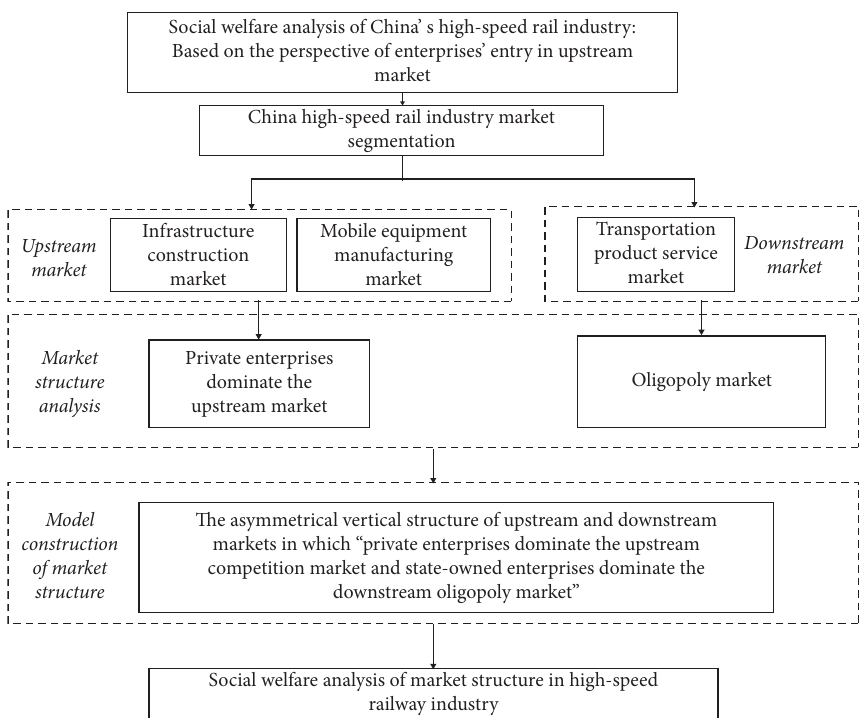
Figure 1: The research framework of this